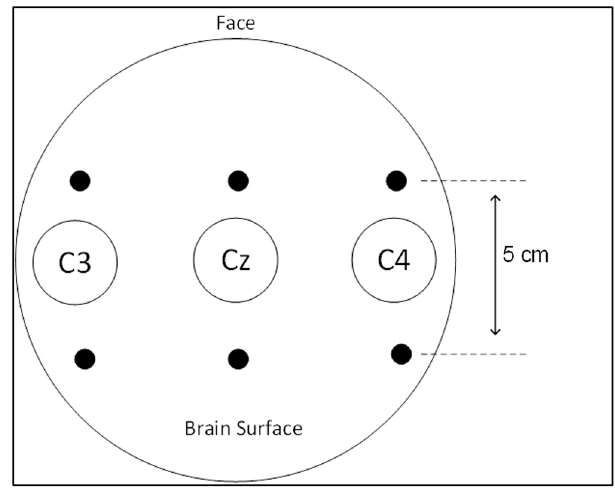
Figure 2. Electroencephalography (EEG) electrode placement.